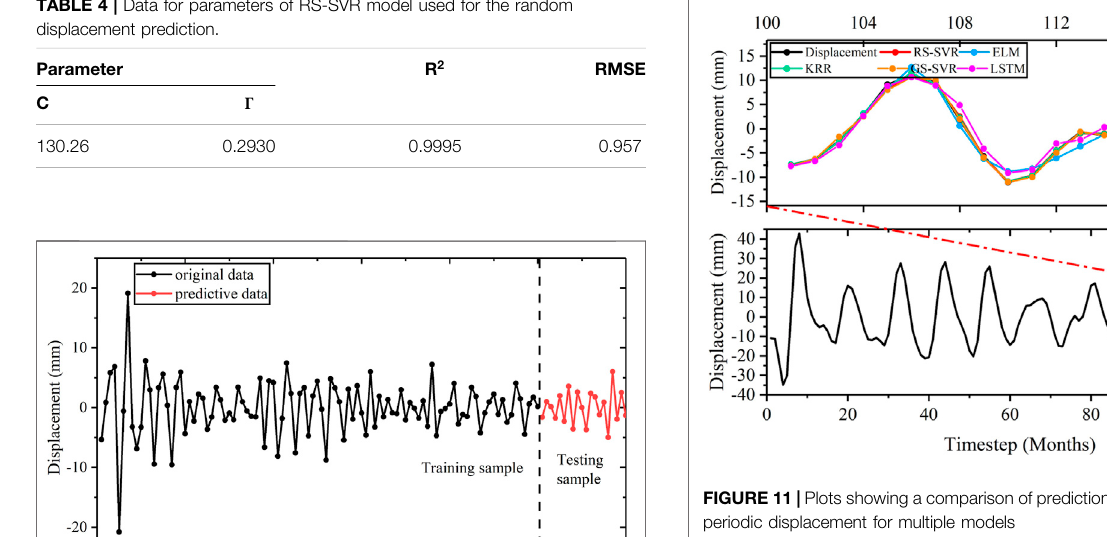
Figure 9 . The smooth curves of the prediction data evidently